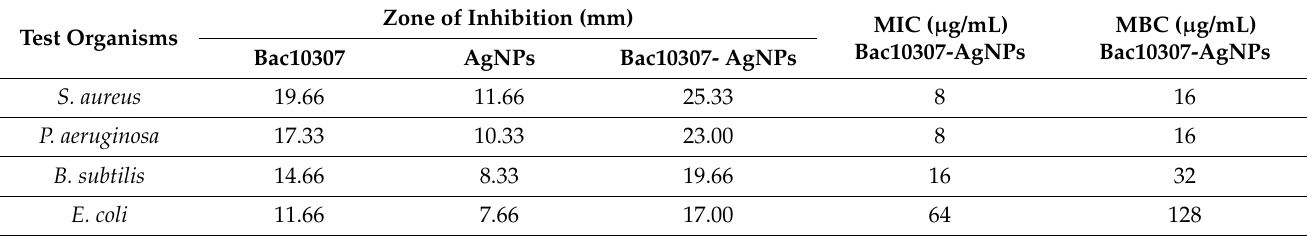
Table 1. Antibacterial activity of synthesized Bac10307 and Bac10307-AgNPs. Zone of Inhibition Test Organisms